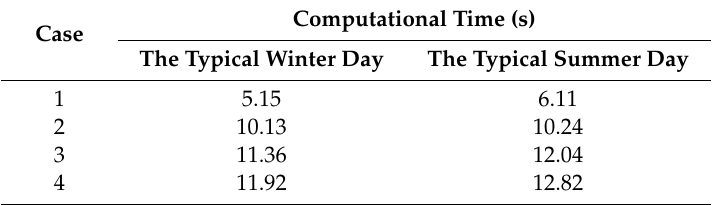
Table 8. The computational time for Cases 1–4 on the typical winter and summer